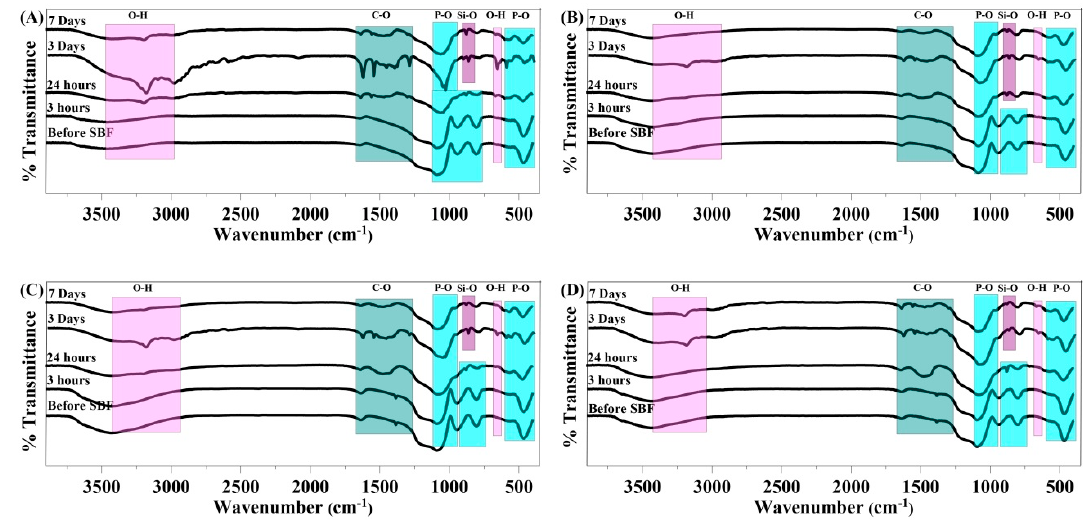
Figure 3. FTIR spectra of the synthesized MBGs before and after immersion in SBF for 3 h, 1 day, 3 days, and 7 days. Ca-MBGs ( A ), Sr-MBG ( B ), Ca-Co-MBG ( C ), and Sr-Co-MBG ( D ).